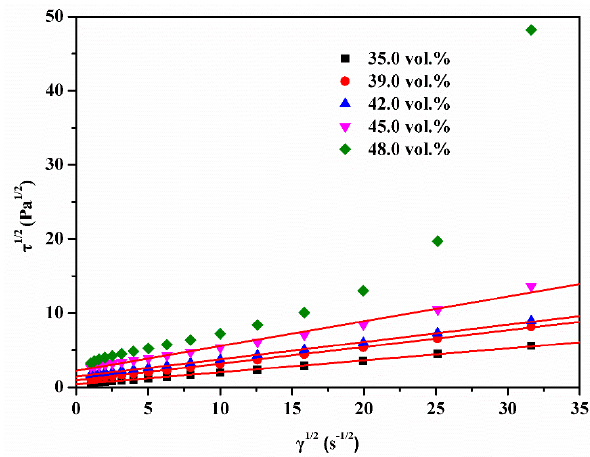
Figure 4. The τ 1/2 - γ − 1/2 dependence for determining the suspension yield stress using the Casson model.